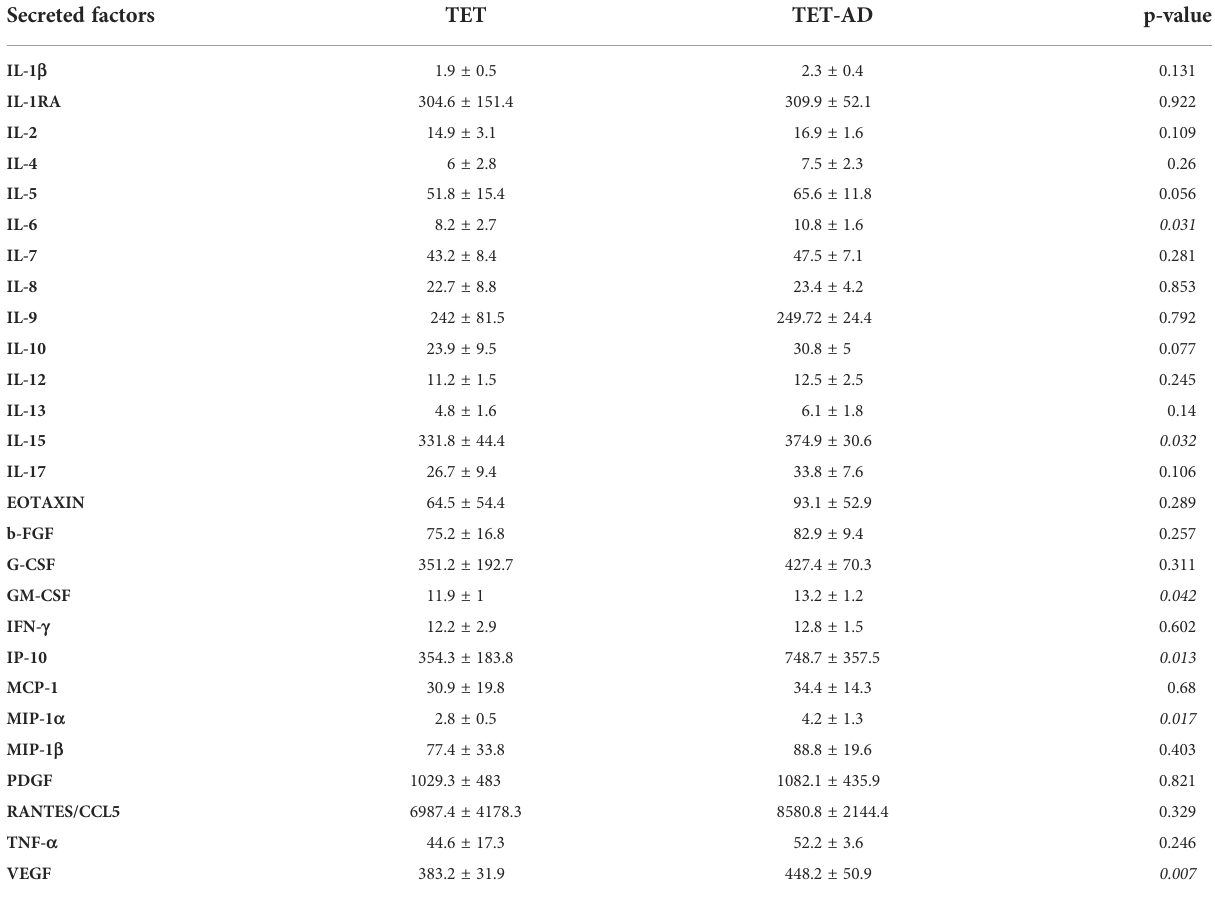
TABLE 3 Serum concentration of cytokines, chemokines, and growth